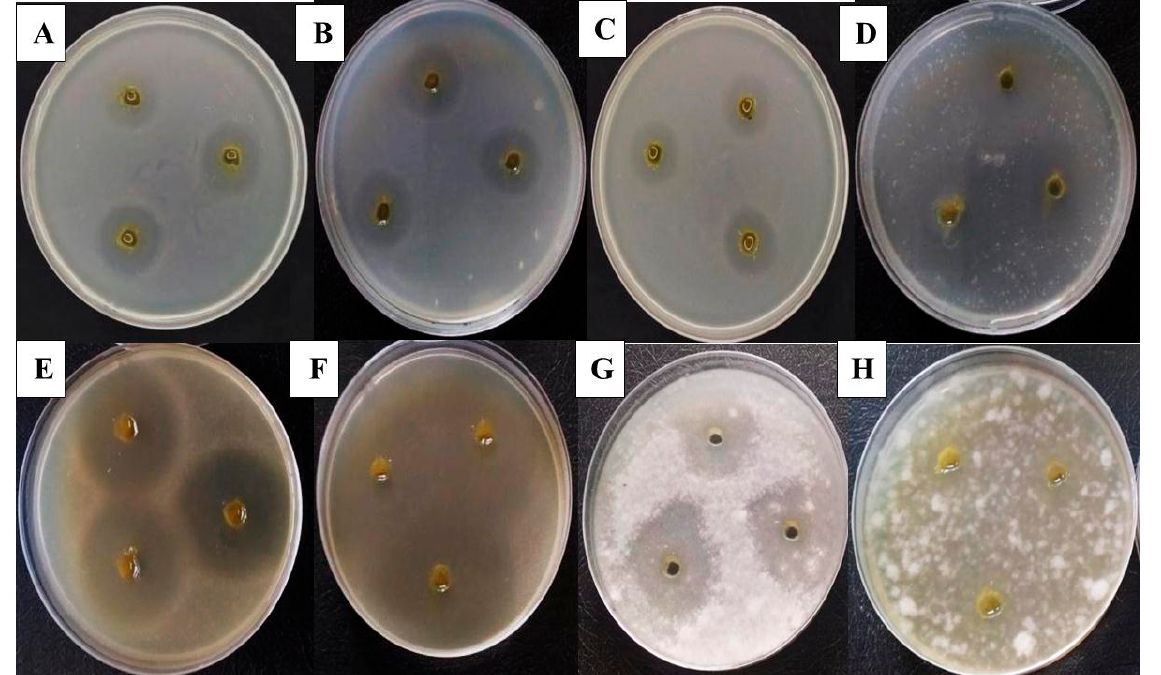
Figure 13. Microbial growth inhibition using infected tomato leaves ( S. lycopersicum L.) by Alternaria cerealis (MT808477) against Gram negative bacteria ( Escherichia coli AUMC B-53 ( A ) and Pseudomonus aeruginosa AUMC B-73 ( B )), Gram pos- itive bacteria ( Staphylococcus aureus AUMC B-54 ( C ) and Staphylococcus epidermids AUMC B-59 ( D )), yeasts ( Candida albi- cans AUMC 1299 ( E ) and Candida tropicalis AUMC 9158 ( F )), and filamentous fungi ( Fusarium oxysporum AUMC 215 ( G ) and Fusarium solani AUMC 222 ( H )).